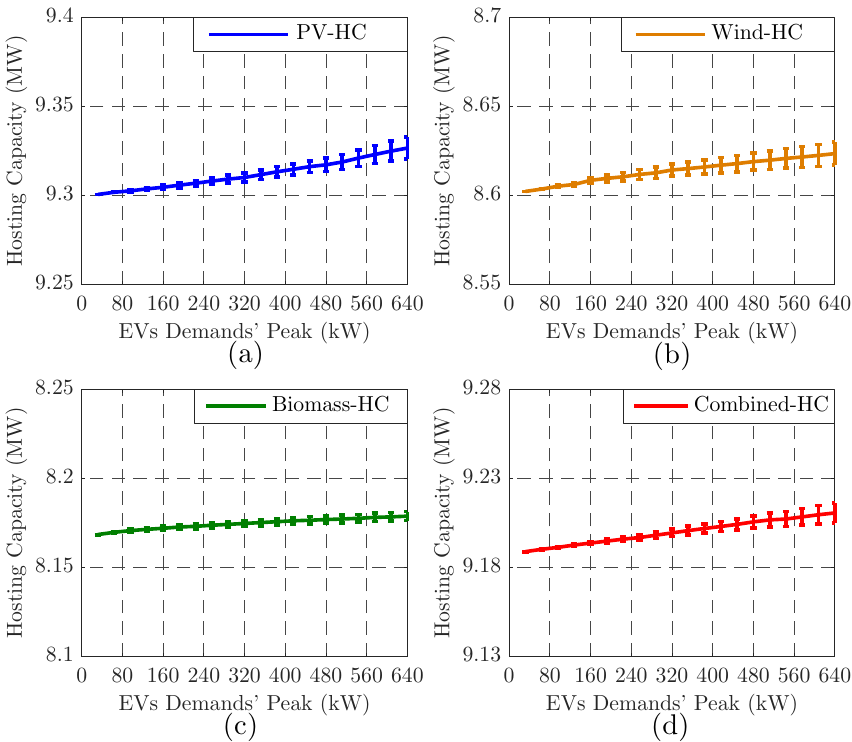
Figure 6. The effect of aggregate demand of residential EVs on the HC obtained via the proposed DRO-HC method with τ = 1% for different technologies including: ( a ) PV; ( b ) wind; ( c ) biomass; and ( d ) combination of PV, wind and